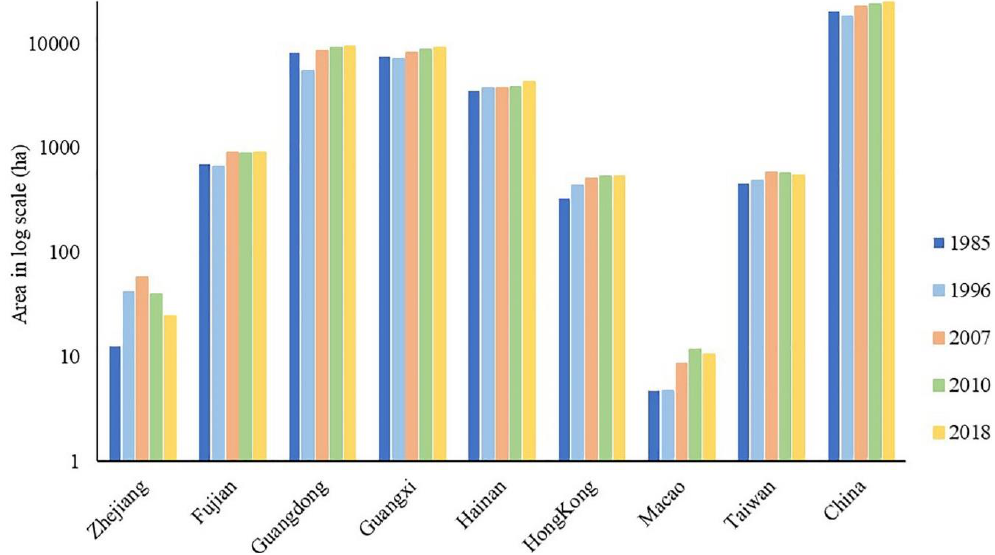
Figure 6. Mangrove areas for each province (district) and the whole coastal zone from 1985 to 2018.